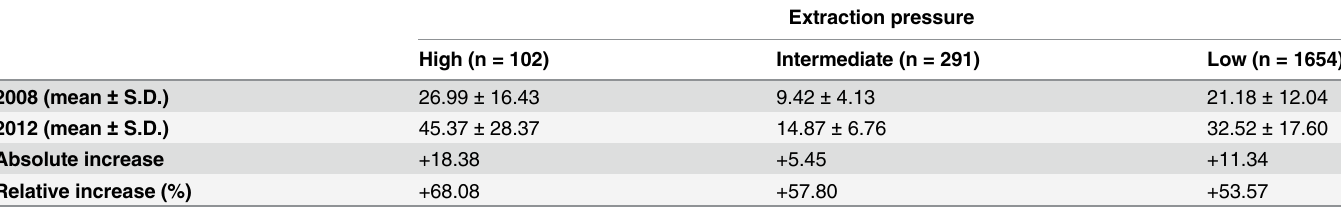
Table 2. Mean biomass increase (Mg ha -1 ) at sites under varying wood extraction